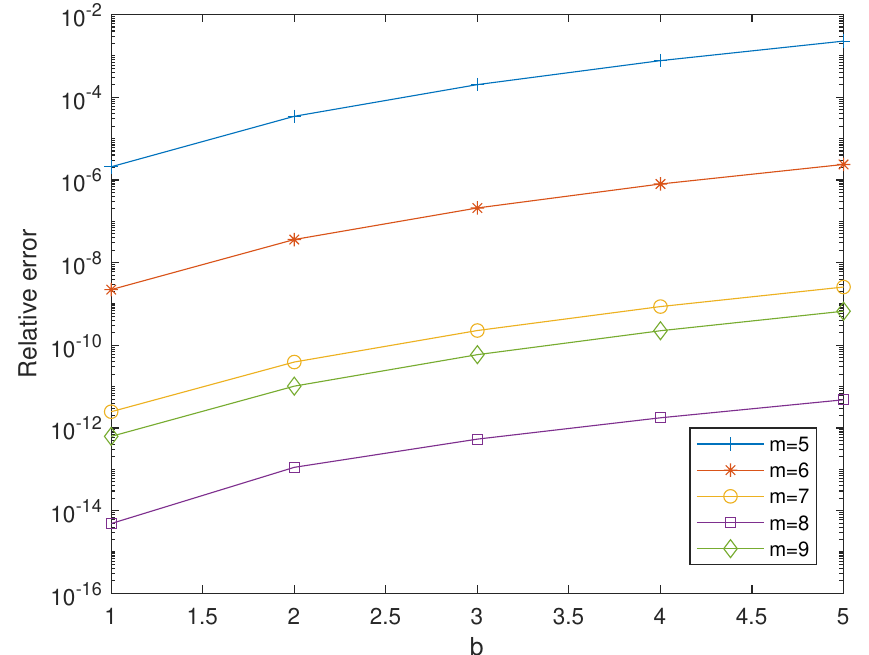
Figure 5. Relative errors for the problem given in Equation (31), for several spline orders ( m 5,6,7,8,9). We discretely vary the value for b 1,2,3,4, and 5, with a fixed stepsize =